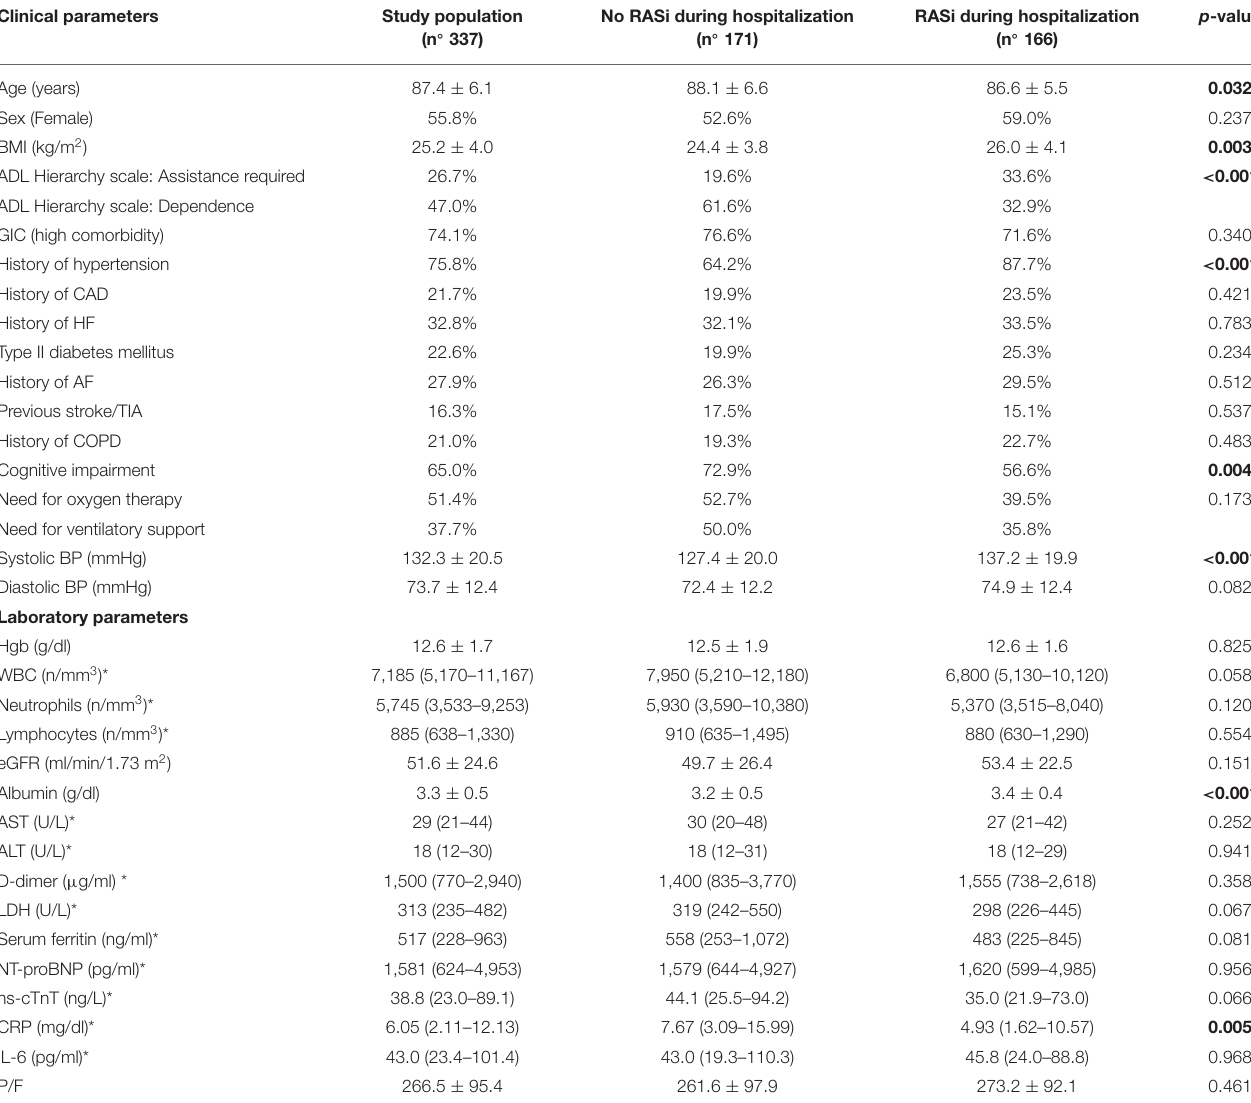
TABLE 1 | General characteristics of the entire study population and according to RASi therapy during hospitalization. Clinical